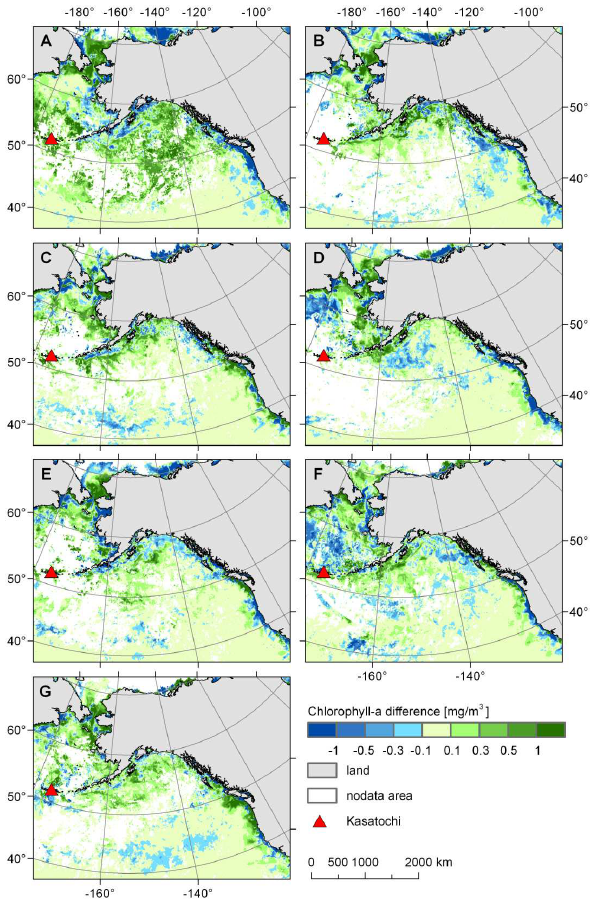
Fig. 4. MODIS Aqua chlorophyll- a [mg/m 3 ]: August 200X minus Figure 4. MODIS Aqua chlorophyll-a [mg/m3]: August 200X minus July 200X. A: 2008, B: 3 July 200X. (A) 2008, (B) 2007, (C) 2006, (D) 2005, (E) 2004, (F) 2007, C: 2006, D: 2005, E: 2004, F: 2003, G: 2002. 4 2003, (G) 2002.